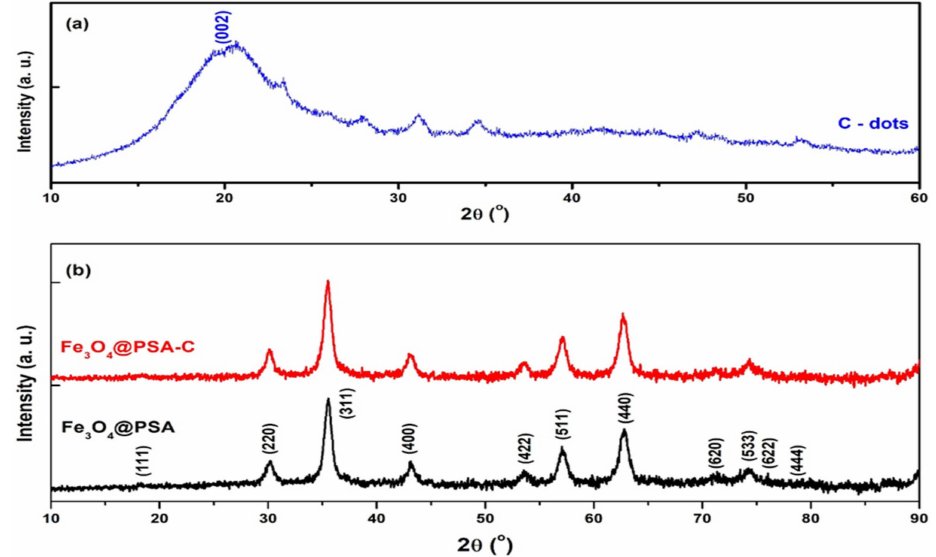
Figure 1. XRD patterns for ( a ) C-dots ( b ) Fe 3 O 4 @PSA-C and Fe 3 O 4 @PSA